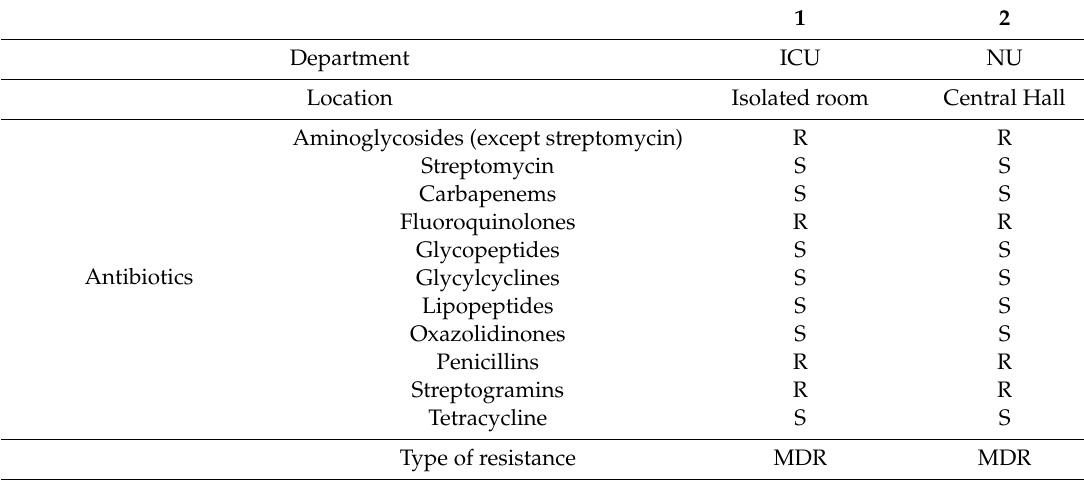
Table 7. Results of Sensitivity Tests for MDR Enterococcus